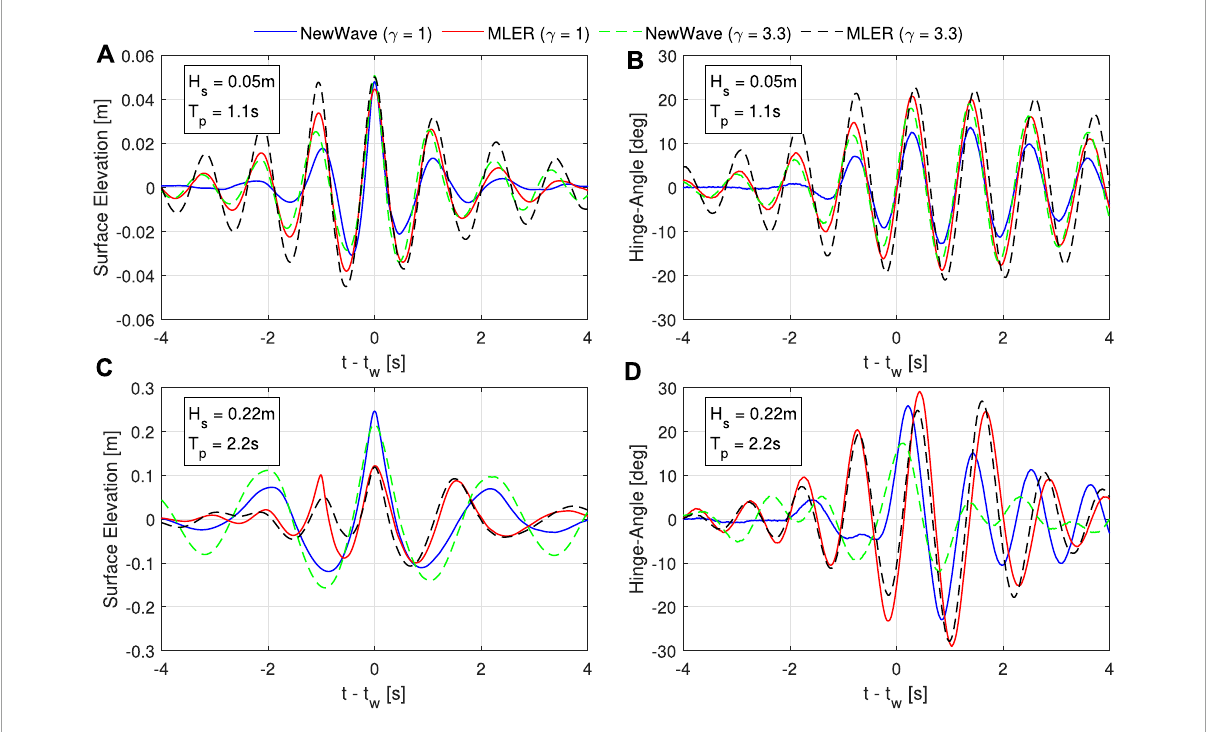
FIGURE 6 Surface elevation (A,C) and hinge-angle (B,D) time series for each single SDWs: NewWave, γ = 1 (blue solid); MLER, γ = 1 (red solid); NewWave, γ = 3 . 3 (green dashed); MLER, γ = 3 . 3 (black dashed). The top row (A,B) presents the Resonance sea state ( T p = 1 . 1s, H s = 0 . 05 m) and the bottom row (C,D) the 50-year sea state ( T p = 2 . 2s, H s = 0 . 22 m). Time is relative to the maximum surface elevation, t w